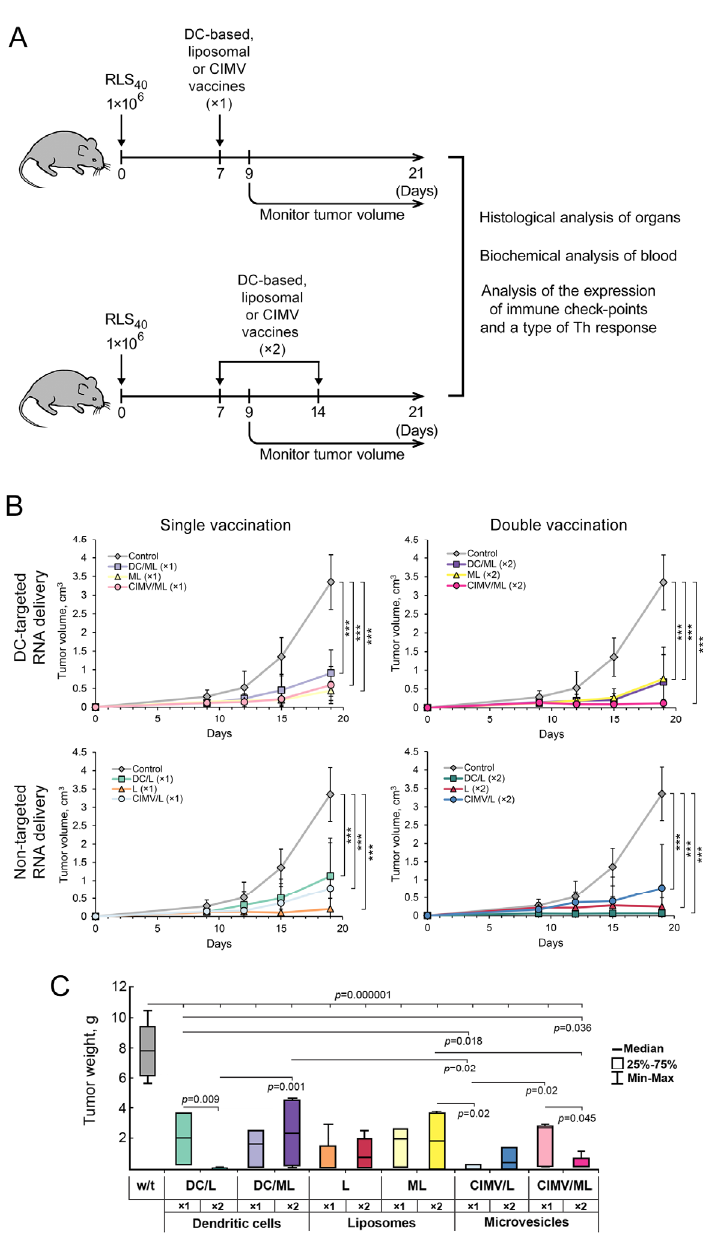
Figure 3. Effect of DC-based and non-cellular vaccines on the growth of RLS 40 tumor in vivo. ( A ) Experimental design. RLS 40 cells (1 × 10 6 ) were implanted i/m into CBA/LacSto mice. Animals received vaccines s/c on day 7 (single vaccination) or days 7 and 14 (double vaccination). ( B ) Tumor growth curves in groups of RLS 40 -bearing mice treated once or twice with DC-, liposome-, or vesicle-based vaccines. Vaccines were prepared using DC-targeted mannosylated liposomes ML or non-targeted cationic liposomes L. Data are presented as mean ± S.D. Data were statistically analyzed using one-way ANOVA with post-hoc Fisher test; p -value indicates a statistically reliable difference: *** p < 0.0005. ( C ) Tumor weight of experimental animals on day 21 of tumor growth. Data are represented as median. Data were statistically analyzed using one-way ANOVA with post-hoc Fisher test, p -values indicate a statistically reliable difference. Color codes correspond to Table